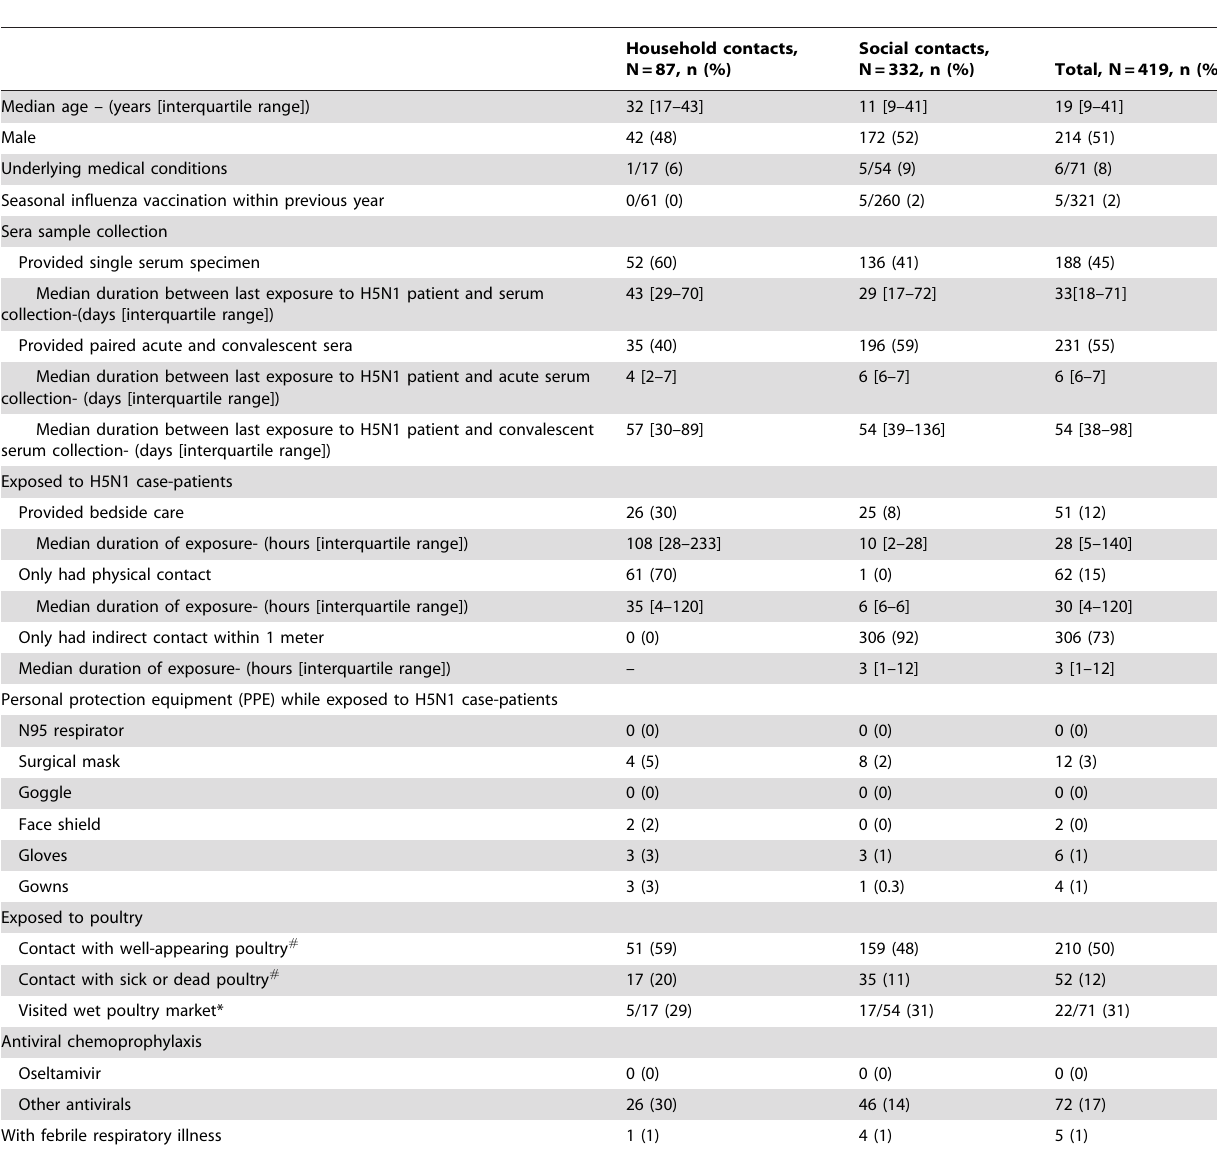
Table 2. Demographic characteristics, exposure history, use of personal protective equipment, and serum collection of 419 close contacts exposed to HPAI H5N1 case-patients, China,